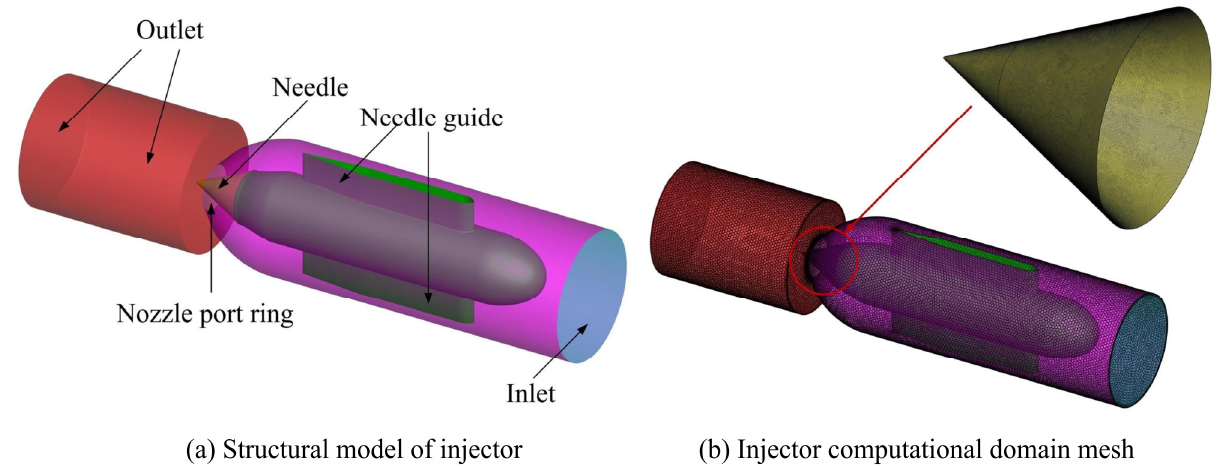
Figure 1. Pelton turbine injector and computational domain grid model.